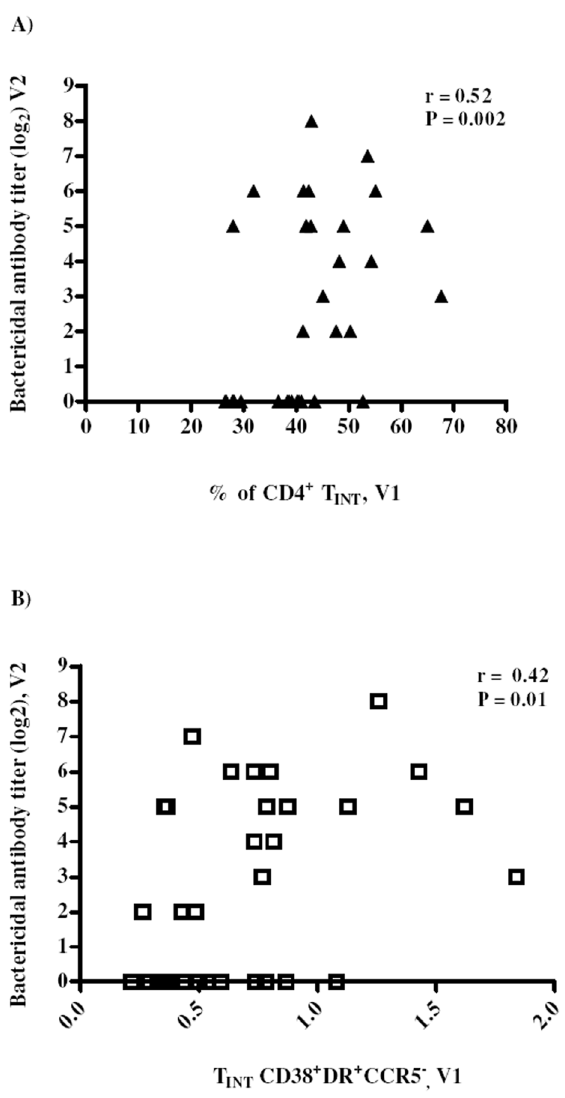
Fig. 3. CD4 + T INT memory subset correlates positively with bactericidal titers. (A) positive correlation between CD4 + T INT frequency and (B) CD4 + T INT CD38 + DR + R5 2 frequency before vaccination (V1) with post- vaccination bactericidal titers (V2). Correlations were analyzed using Sperman rank test.